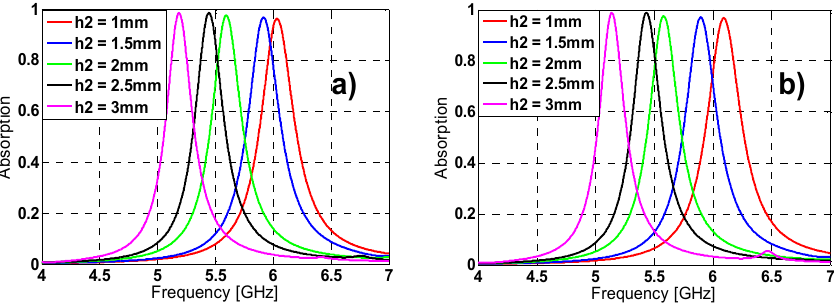
Figure 3. Absorption results in simulation for different lengths of h2 for both ( a ) TE ( b )